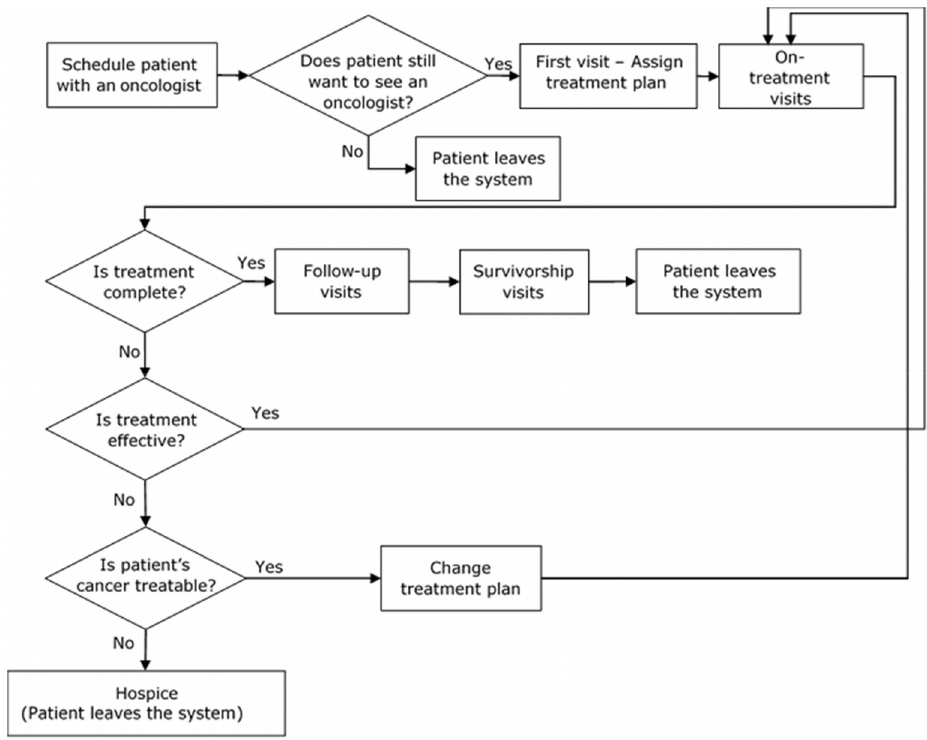
Figure 2. Patient flow in the simulation